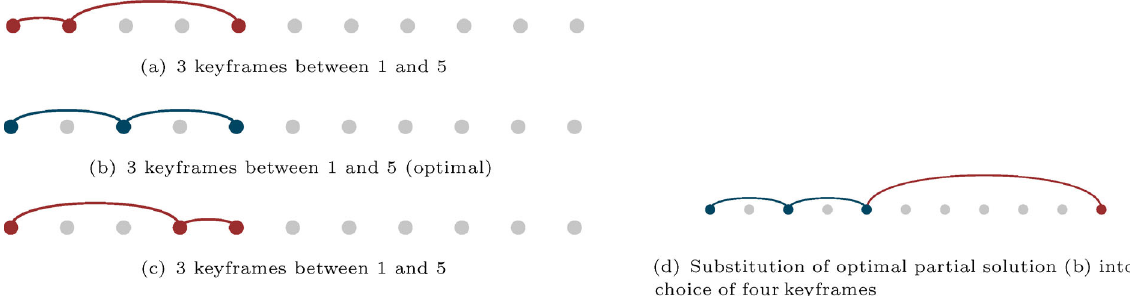
Fig. 5 Salient Poses enumerates selections of keyframes to find those that are optimal. While the computational cost of such a process would otherwise be combinatorial, the solution for a subset of keyframes can be reused during the search for a larger set. This figure illustrates a step in this computation. (a)–(c) schematically show three choices of keyframes for a motion beginning at frame 1 and ending at frame 5. The arcs encode the cost of approximating that span of the motion using the keyframes that bound it. Choice (b) is selected as optimal here. A later step of the search (d) considers the best set of four keyframes lying between frames 1 and 11. In cases where there are no keyframes between 5 and 11, the previously found optimal solution for frames 1 ... 5 is substituted into this search, thereby limiting the combinatorial